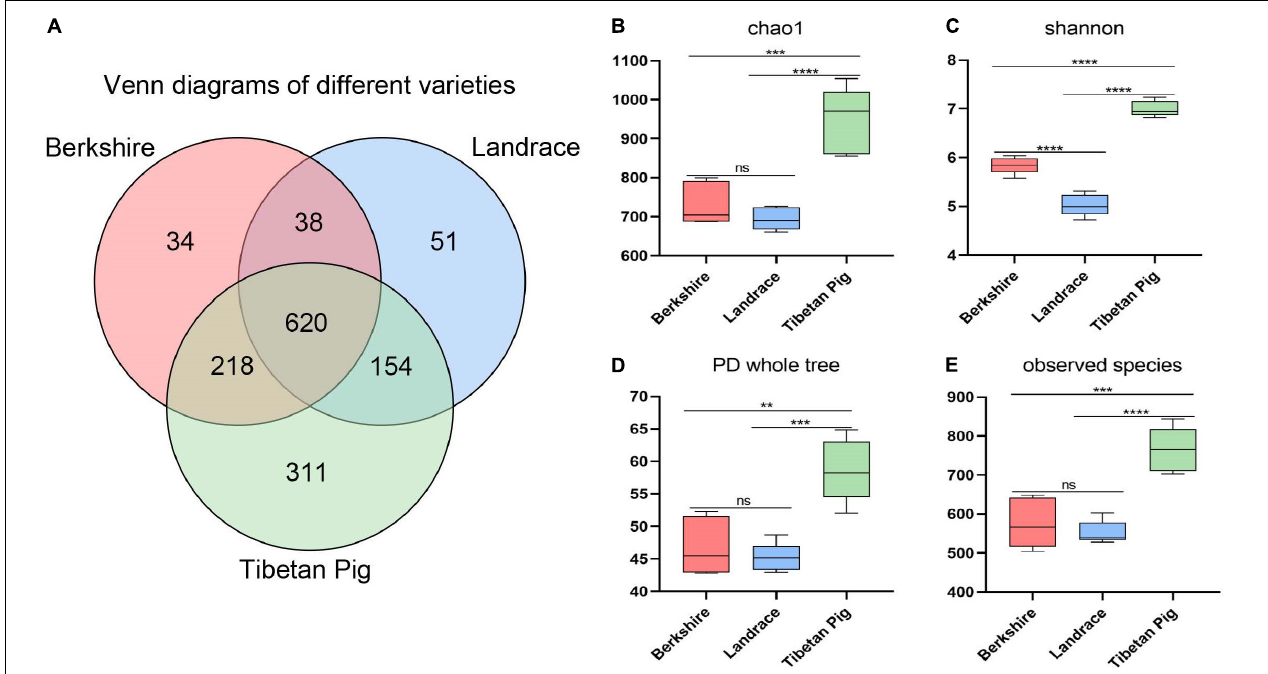
FIGURE 1 | Venn map and alpha-diversity analysis. Venn map of Berkshire pigs, Landrace pigs, and Tibetan pigs on day 350 (A) . Chao1 observed number of species (B) . Shannon–Wiener index (C) . PD whole tree (D) . Observed species (E) . One-way ANOVA was employed for the statistical analysis (ns, non significant; ** p < 0.01; *** p < 0.001; **** p <